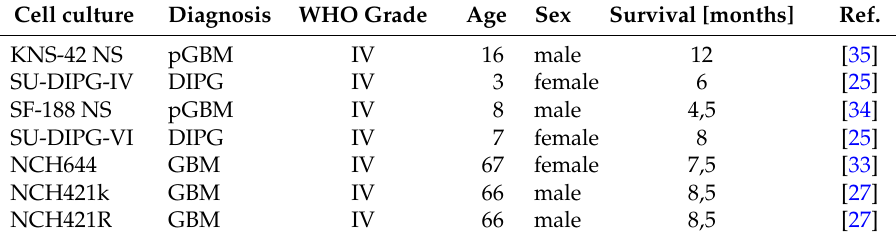
Table 1. Clinical data related to the different tumor tissue donors.